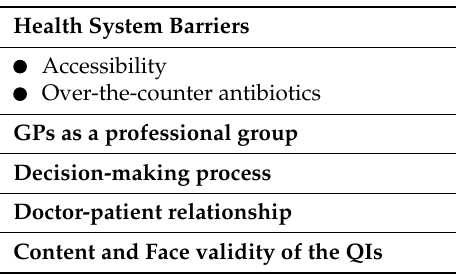
Table 2. Emerging themes and subthemes regarding